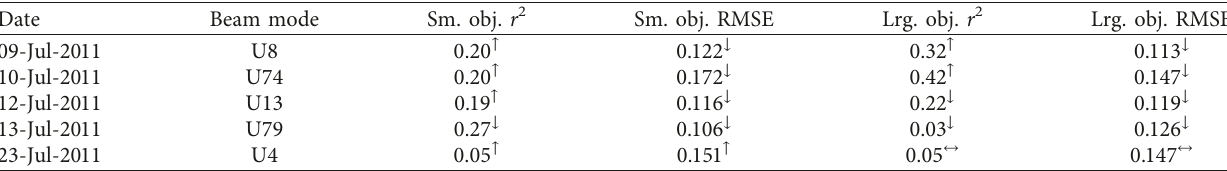
Table 5: Results of the ANN applied to the different scenes/dates at Cape Collingwood in 2011, after removal of outlier moss plots. Date Beam mode